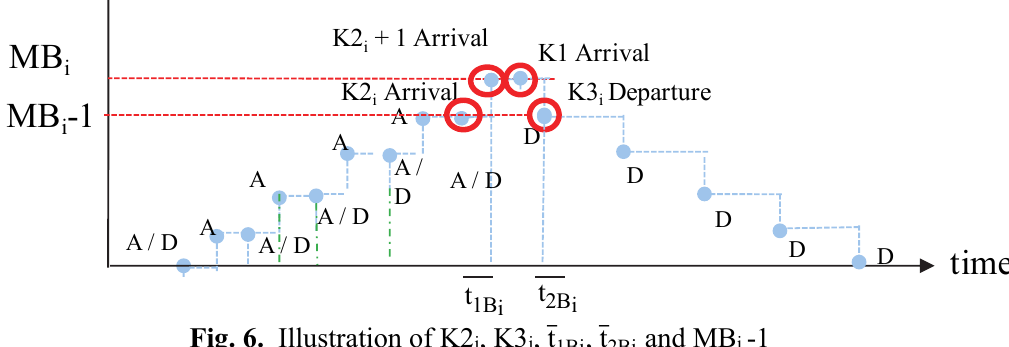
, t ̅ and MB i 1Bi 2Bi